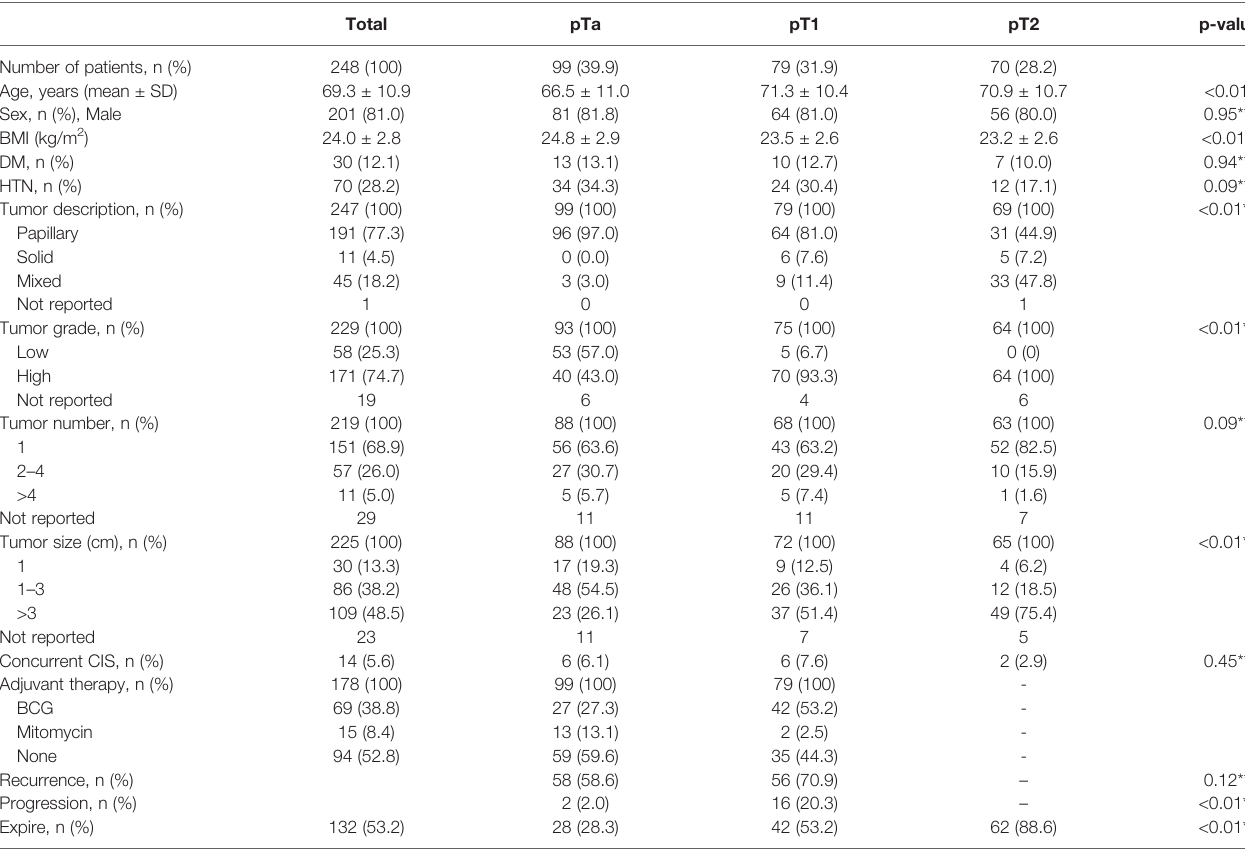
TABLE 1 | Patient